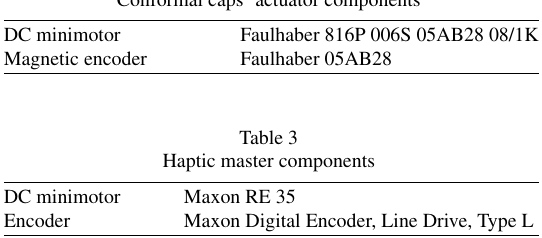
Table 2 Conformal caps’ actuator components